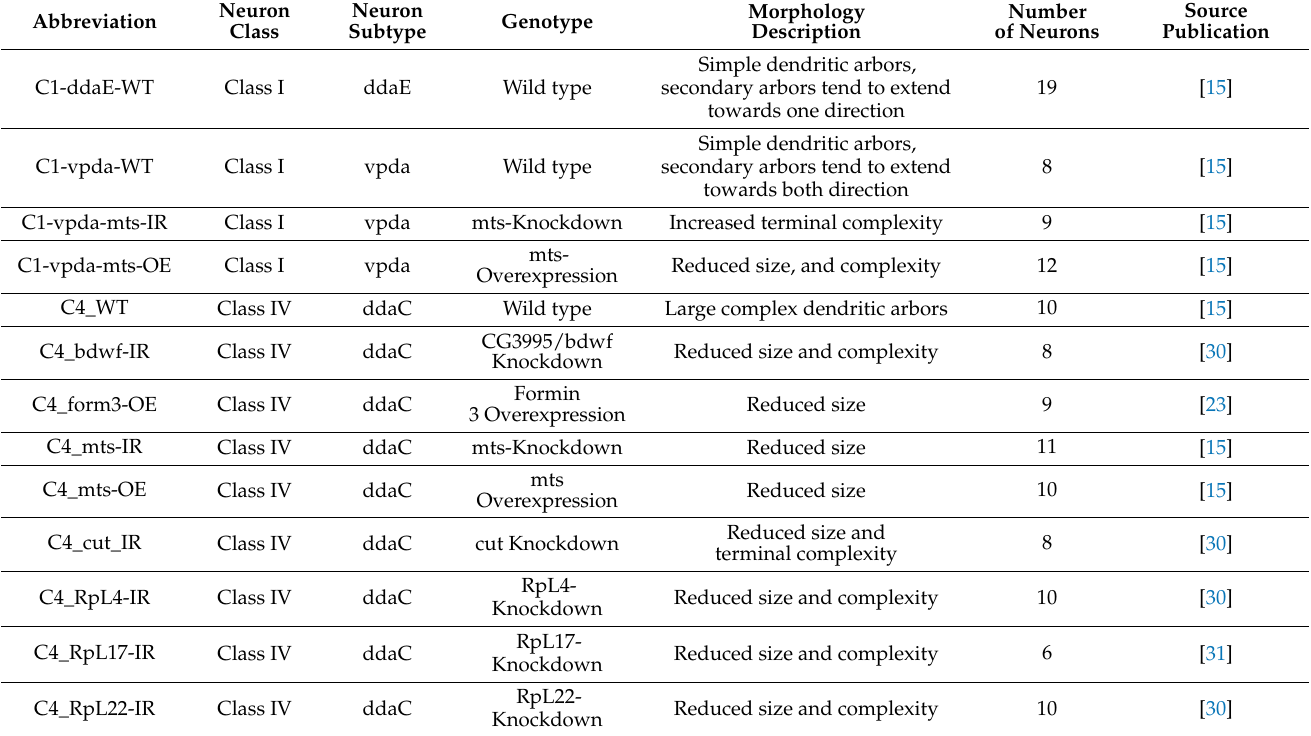
Table 1. Abbreviation, neuron class, subtype, genotype, morphological characteristics, number of neurons, and data sources information for the 17 neuron groups used in this